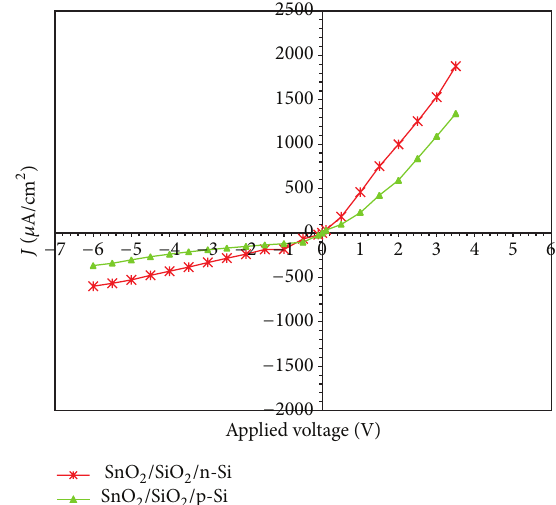
Figure 4: 𝐽 - 𝑉 characteristic under forward and reverse bias for both MIS